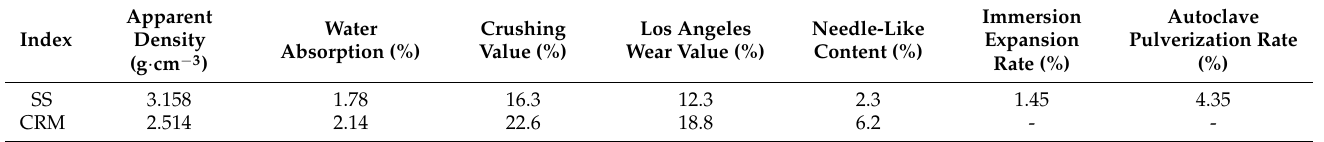
Table 3. Physical properties of materials representing performance indices.